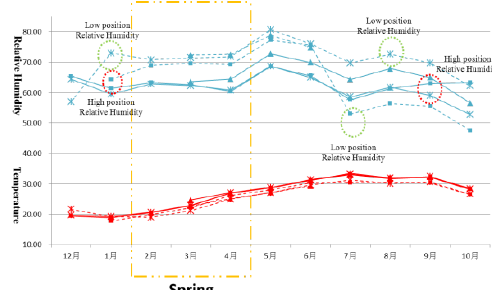
Figure10 、 Temperature and relative humidity run chart of high and low position in Beigang Chao-Tian Temple